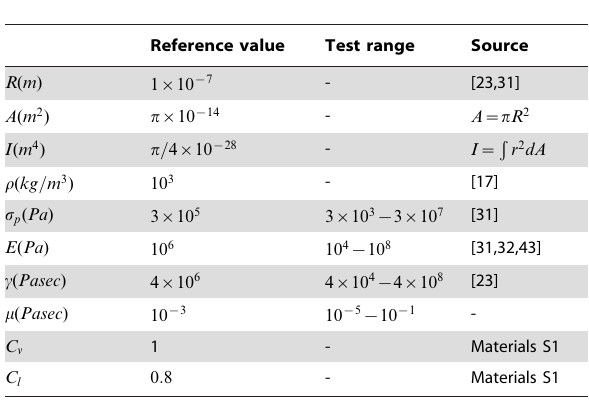
Table 1. Parameters values for the present